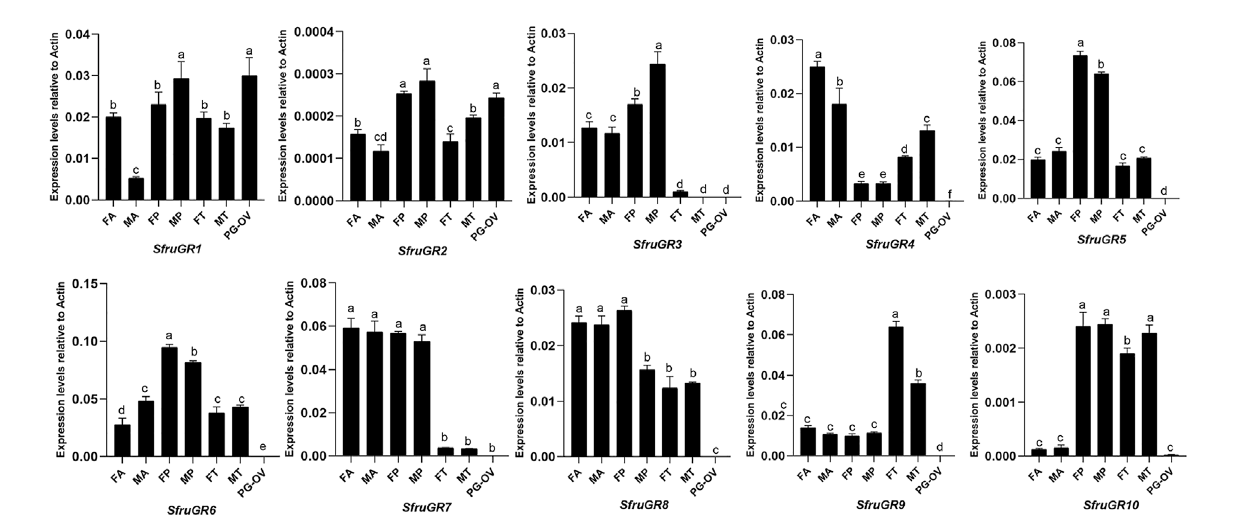
FIGURE 6 Expression patterns of candidate SfruGRs in different chemosensory tissues of adult S . frugiperda . FA: female antennae, MA: male antennae, FP: female proboscises, MP: male proboscises, FT: female tarsi, MT: male tarsi, PG-OV: female pheromone gland-ovipositor. Different letters indicate